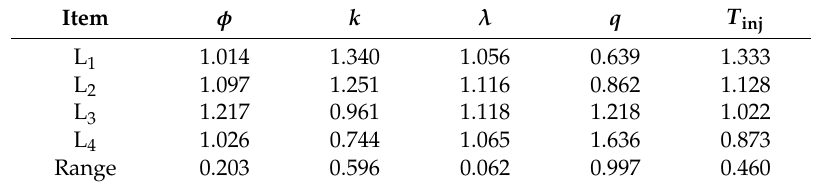
Table 9. Mean effects of different levels of conditions on the pump power at t = 20 years.